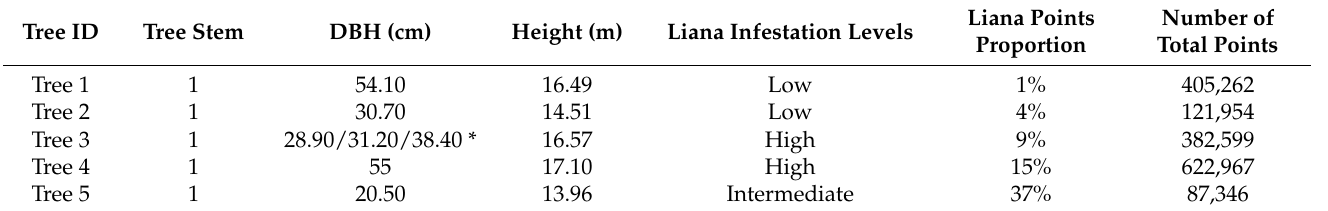
Table 1. Description of the trees with liana infestation collected in Santa Rosa National-Park Environmental Monitoring Supersite, Costa Rica.